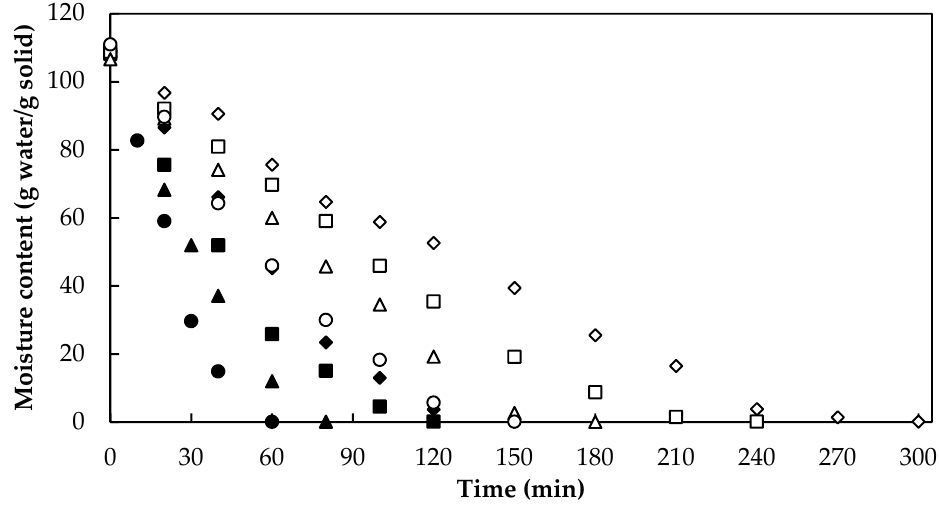
Figure 2. Drying curve of Aloe vera gel slabs with 5 mm (60 °C, ♦ ; 70 °C, ■ ; 80 °C, ▲ ; 90 °C, ● ) and 10 mm (60 °C, ◊ ; 70 °C, □ ; 80 °C, ∆ ; 90 °C, ○ ) thickness.